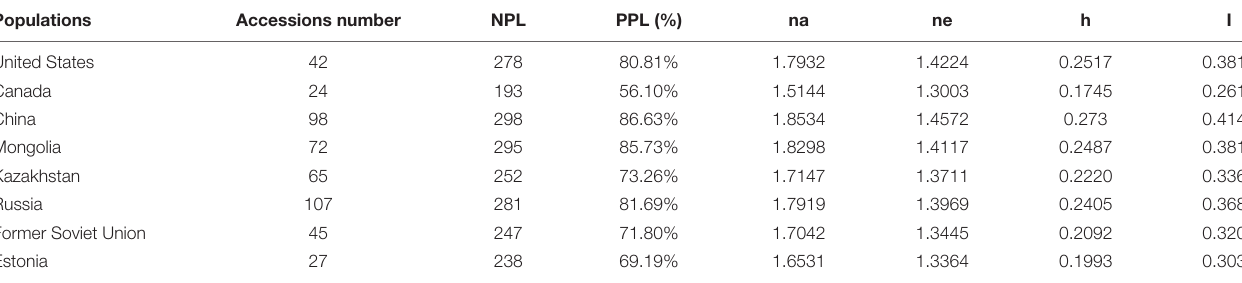
TABLE 6 | Genetic diversity of Psathyrostachys juncea in different regions.